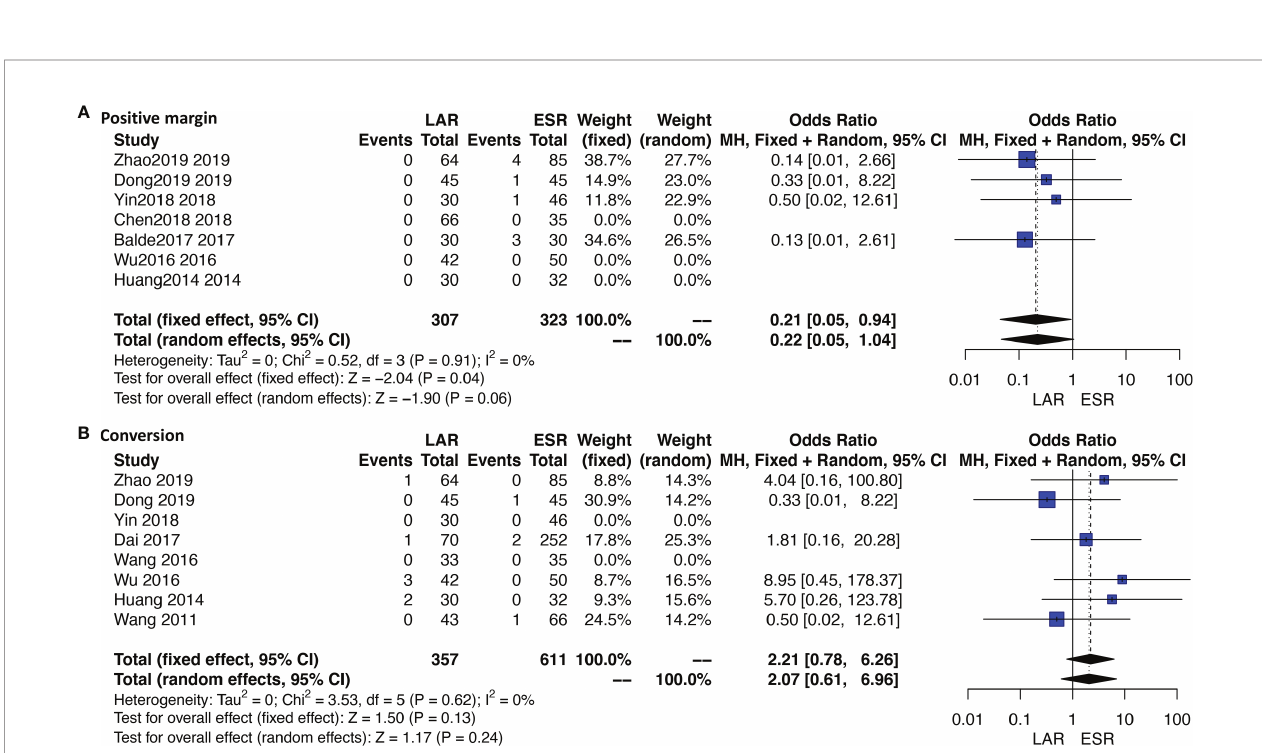
FIGURE 4 | Forest plots of direct meta-analysis comparing rates of (A) positive margin and (B) conversion between endoscopic resection and laparoscopic